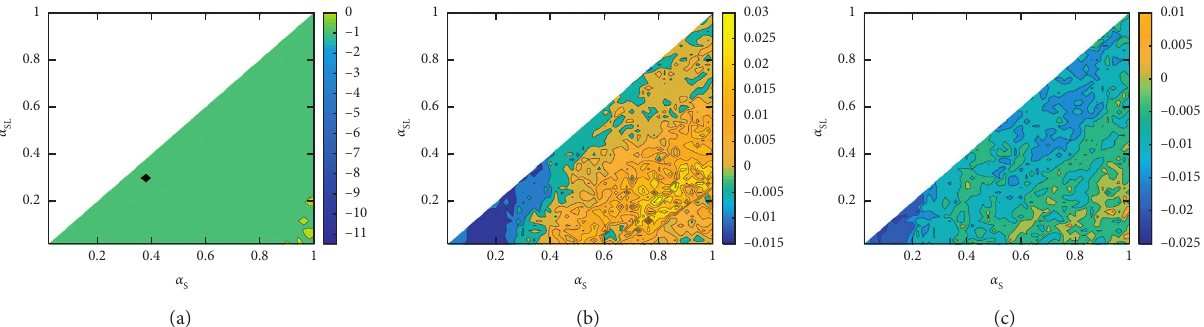
Figure 8: LLE diagram of supply chain nodes under the scenario of random demand obeying normal distribution from the global decision � 4. (a) The retailer’s LLE chart. (b) The LLE chart of the distribution center. (c) The LLE chart of the perspective when G d � 1 and G 2 combined system from the decision